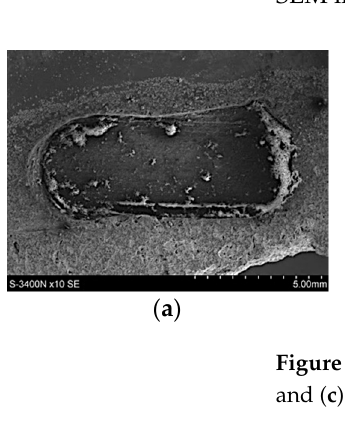
Figure 18. Microstructure of AlSi12/GC p composite: ( a ,) LM; ( b ) SEM. 4. Conclusions The conducted tribological investigation under dry friction conditions allowed for an evaluation of the behavior of materials in extremely unfavorable working conditions. The obtained results and their analysis clearly indicate that the highest COF was rec- orded for the un-reinforced matrix, and the average value was μ = 0.42. In this case, a high- volume loss of the material was also observed, at the level of 19 mm 3 . It was shown that introducing reinforcement particles into the AlSi12 matrix alloy significantly changed the friction conditions. However, the glassy carbon particles (GC p ) decreased the COF (aver-